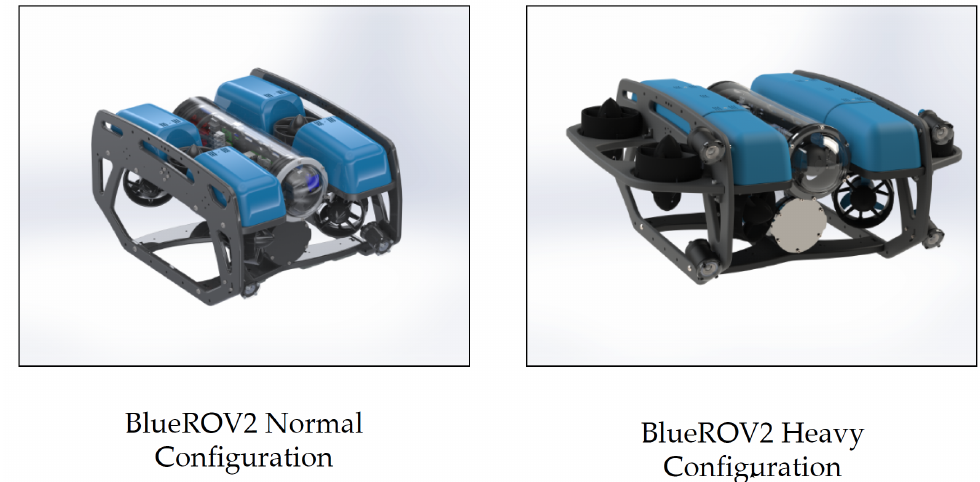
Figure 2. Two illustrations of the BlueROV2 with and without heavy configuration,